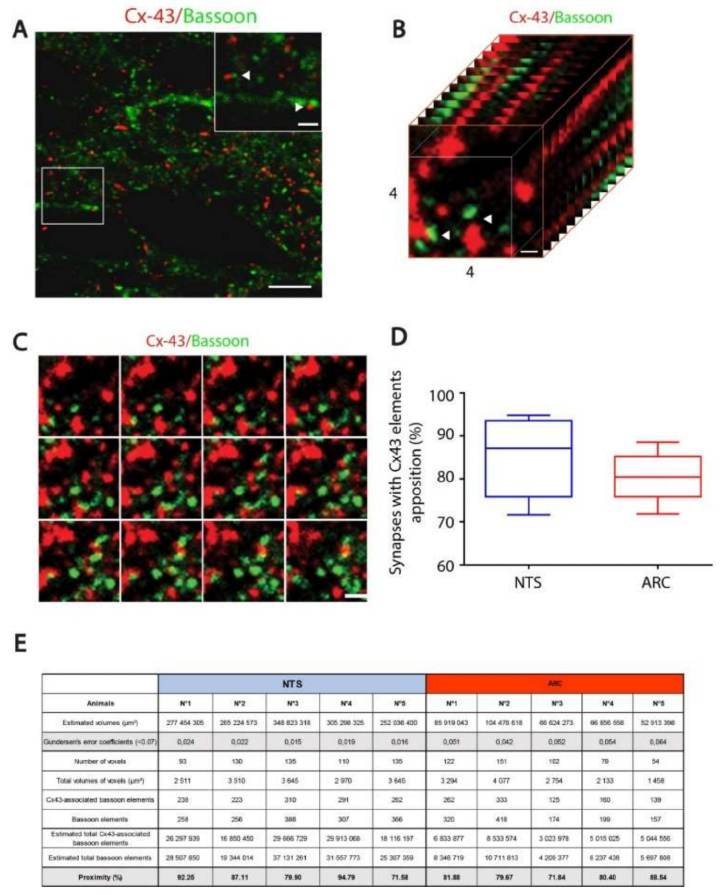
Figure 3. ( A ): Confocal images of connexin-43 (Cx43) (red) and bassoon (green) double labeling immunohistochemistry performed within the nucleus tractus solitarius (NTS). Scale bar: 5 µ m.